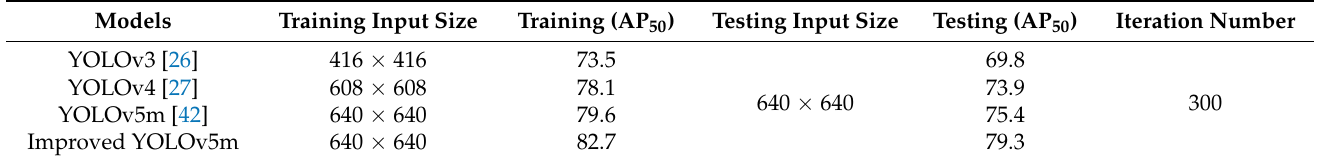
Table 8. Average precision of YOLO models with augmented wildfire smoke